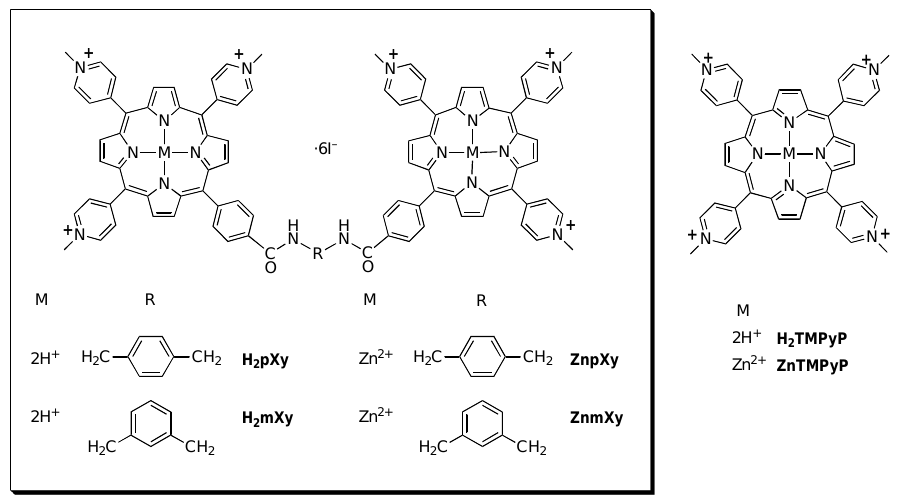
Figure 1 . Cationic porphyrins in this study